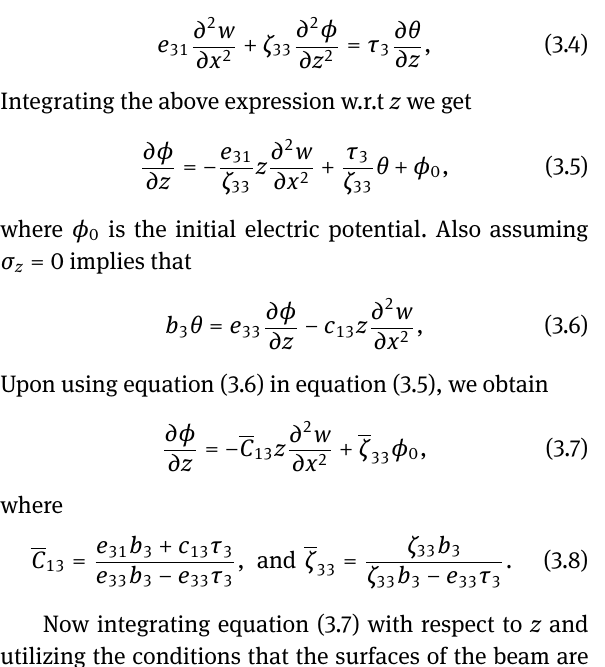
Figure 1: Geometric Structure of Beam Under Deflection.